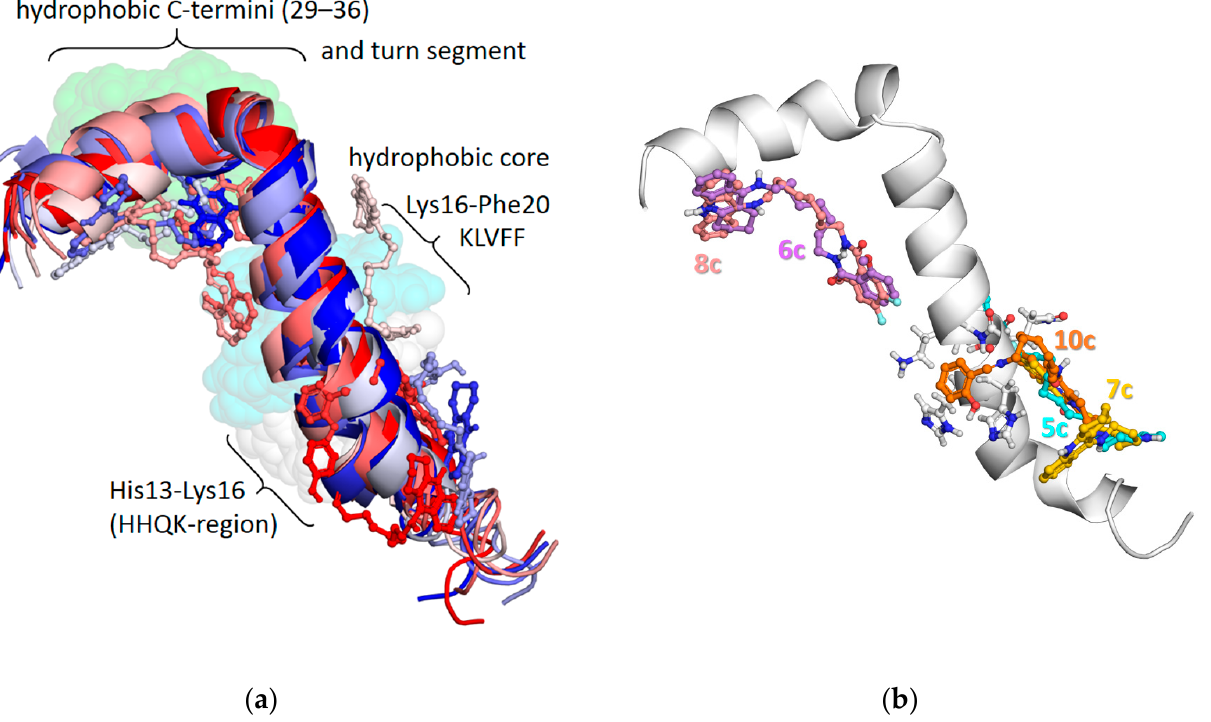
Figure 5. Results of molecular docking of compound 10c to all 10 conformers of an α -helical soluble monomeric form of A β 42 (PDB ID 1IYT; solution NMR structure). The color gradually changes from red through white to blue from the first to the tenth A β 42 conformer) ( a ); and of compounds 5c (car- bon atoms are colored cyan), 6c (carbon atoms are colored lilac blue), 7c (carbon atoms are colored yellow), 8c (carbon atoms are colored pink), and 10c (carbon atoms are colored orange) to the second conformer of A β 42 ( b ).